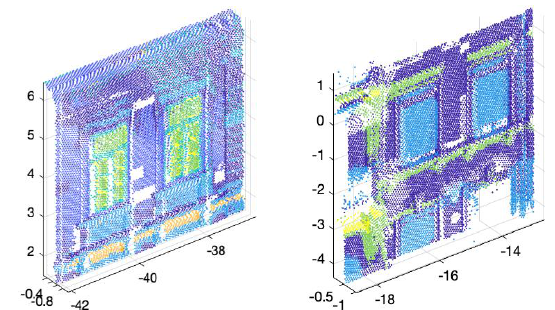
Figure 4: Examples of local analyses of thermal attributes of points (one colour per extracted